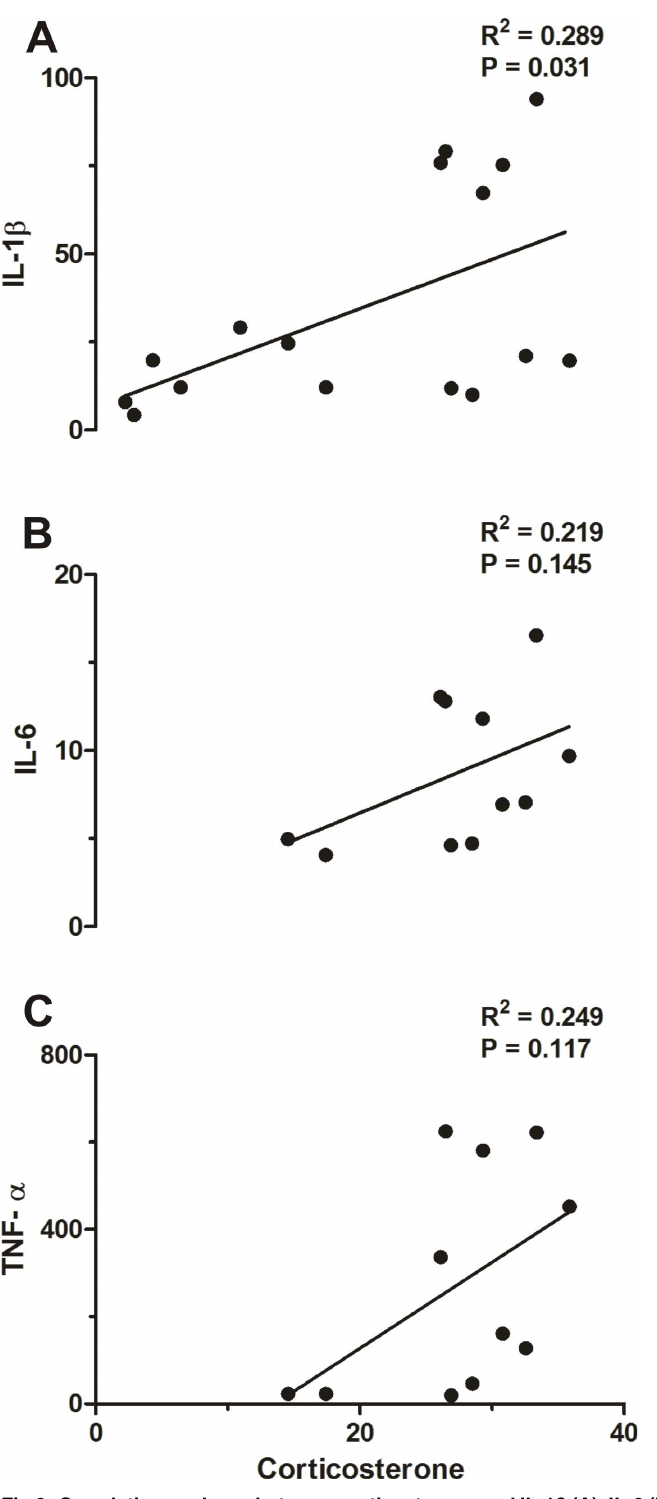
Fig 8. Correlation analyses between corticosterone and IL-1 β (A), IL-6 (B) and TNF- α